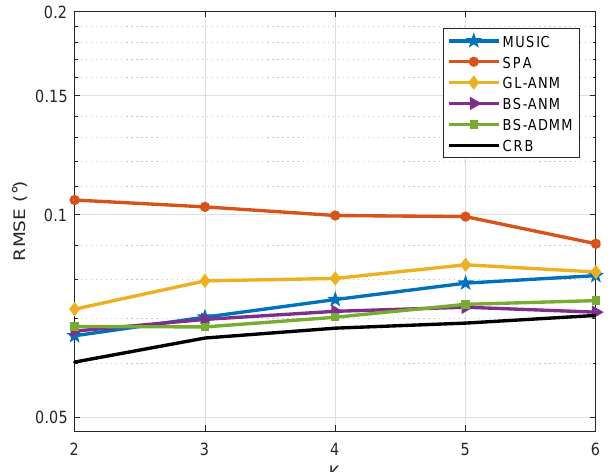
Figure 6. RMSE comparison for uncorrelated sources at [ − 30 ◦ , − 24 ◦ , · · · , ( 6 K − 36 ) ◦ ] , J = 100 and SNR = 0 dB when the number of sources varies from 2 to